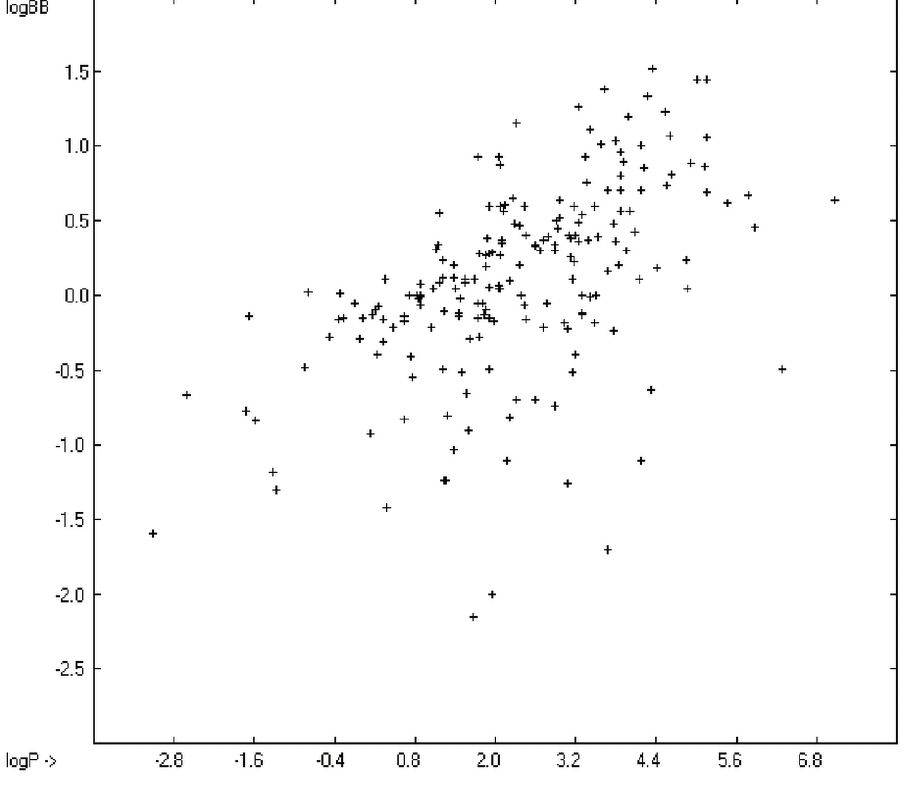
Figure 19. Correlation diagram of logP against logBB (N = 198, R 2 =